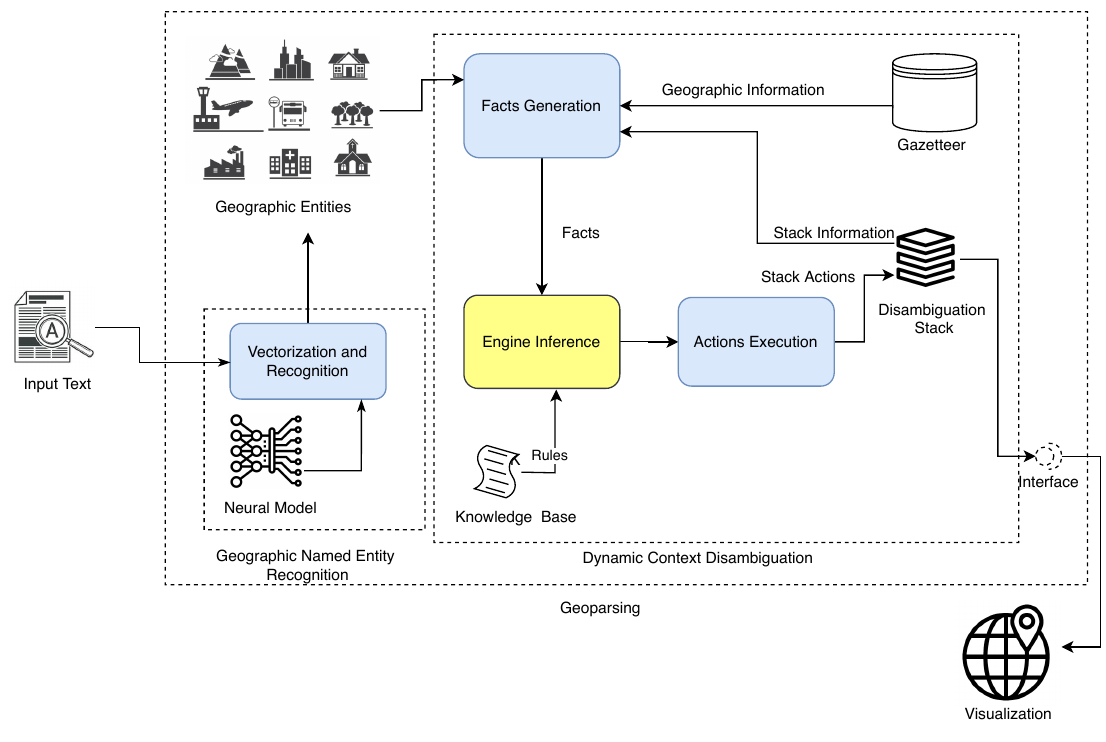
Figure 1. Proposal